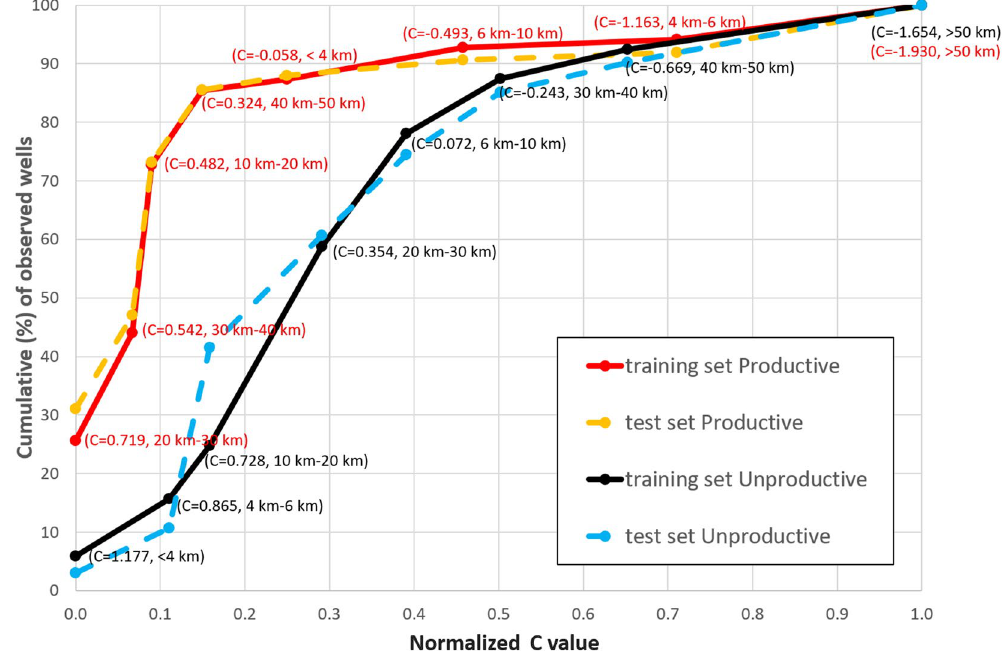
Figure 3. Success-rate curves and prediction-rate curves for the 3D scenario. Success-rate curves (in red for productive and black for unproductive) and prediction-rate curves (in orange for productive and blue for unproductive) of C distributions calculated for the 3D distance